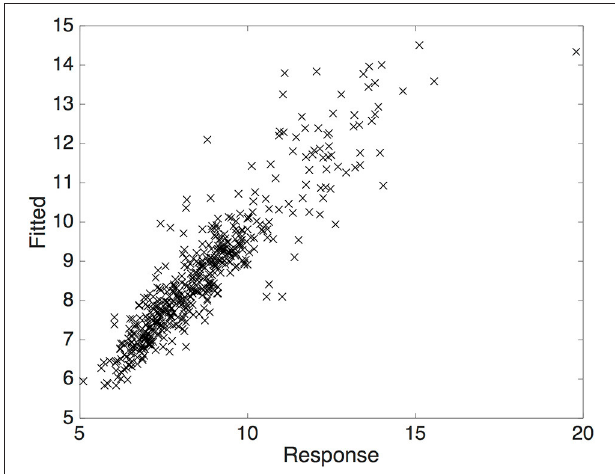
FIGURE 3 | The fitted vs. observed response values from the linear mixed effects model form an almost 45-degree angle indicating a good fit.